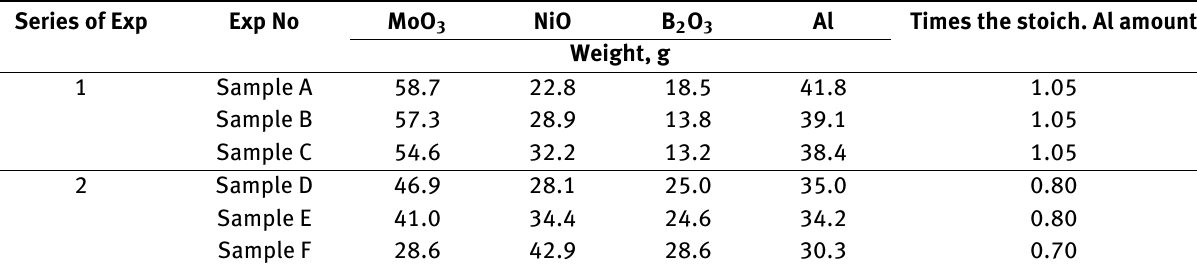
Table 1: The amounts of the initial raw materials amount used in the experiments Series of Exp Exp No MoO 3